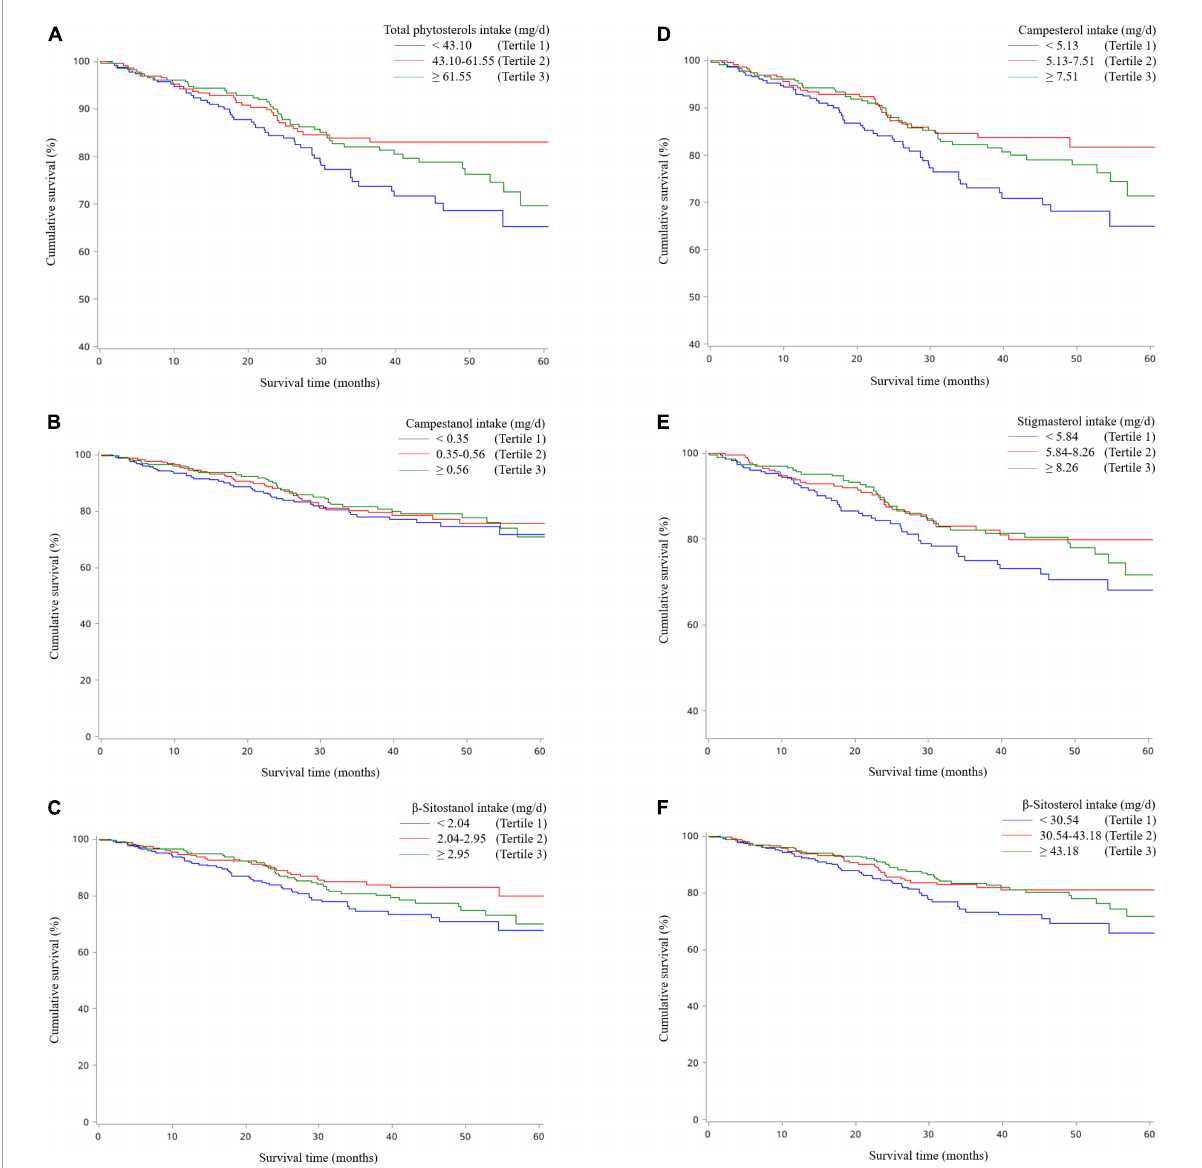
FIGURE2 Kaplan–Meier survival curves for total phytosterols (A) , campestanol (B) , β -sitostanol (C) , campesterol (D) , stigmasterol (E) , and β -sitosterol (F)